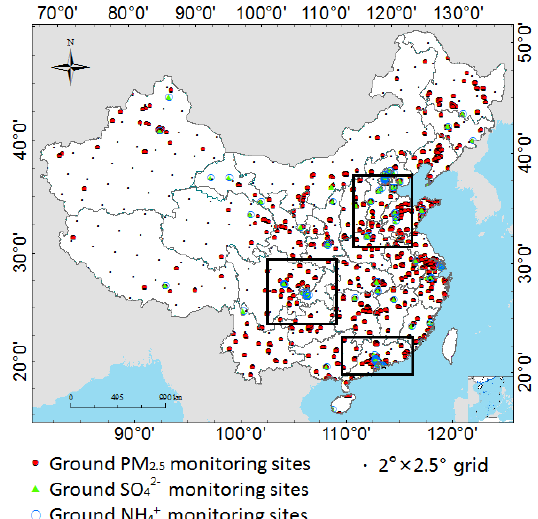
Figure 1. Spatial distribution of ground PM 2.5 and chemical component monitoring sites. Red solid circles denote sites with PM 2.5 data available from 2004 to 2014. Green triangles and blue open circles are similar to the red solid circles but for SO 42− and NH 4+ , respectively. Three black boxes denote the regions on which our study